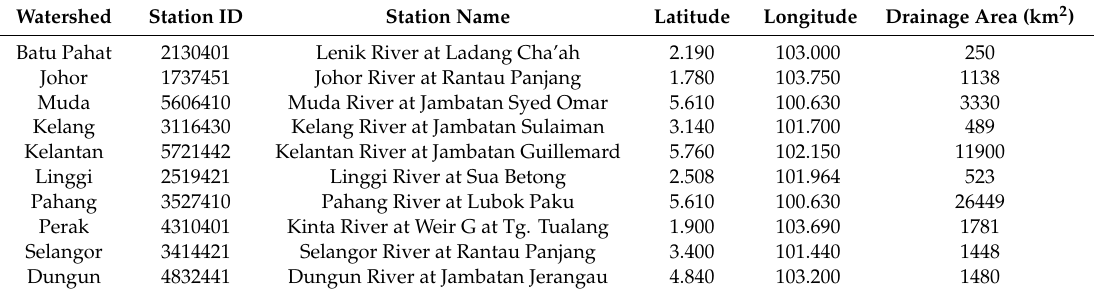
Table 2. Summary of the streamflow stations that were used for the calibration and validation of the WEHY watershed hydrology model for the 10 watersheds under